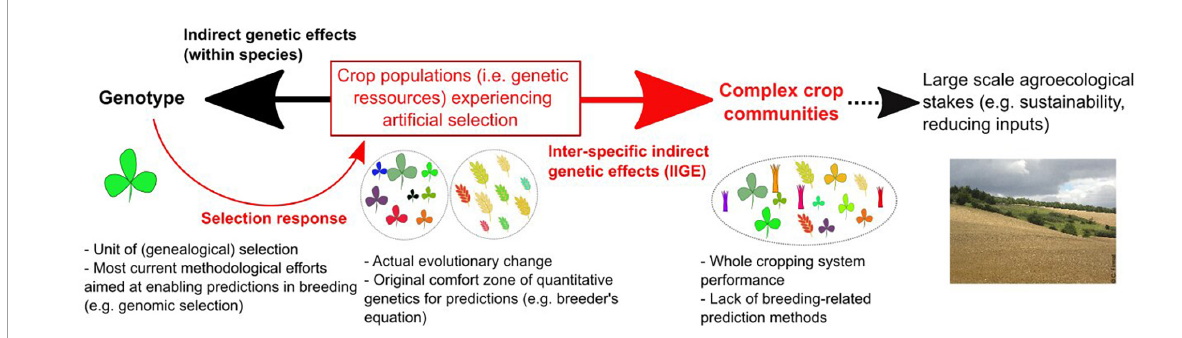
FIGURE1 The context of the present survey and its scope (represented by red arrows and texts in the figure). Current plant breeding activities can be viewed as lying under a double-constraint between, on the one hand, technological advances that favors predictions at the genotypic level (black arrow pointing left) and, on the other hand, broad-scale agroecological stakes requiring predictions of plant breeding effects at much higher biological levels (red arrows pointing right). Population level, as the level of evolutionary changes (i.e., the whole set of genetic resources that can be controlled by breeders), lies at the core of this double-constraint. The bold red arrow indicates the focus of the present survey, i.e., models predicting changes in the performances of a complex crop community resulting from any type of breeding-induced evolutionary